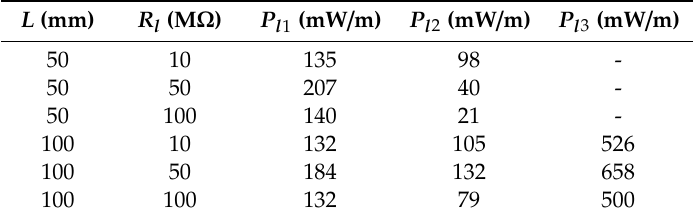
Table 9. Estimated piezoelectric power output for the plates L = 50 mm, L = 100 mm. L (mm)